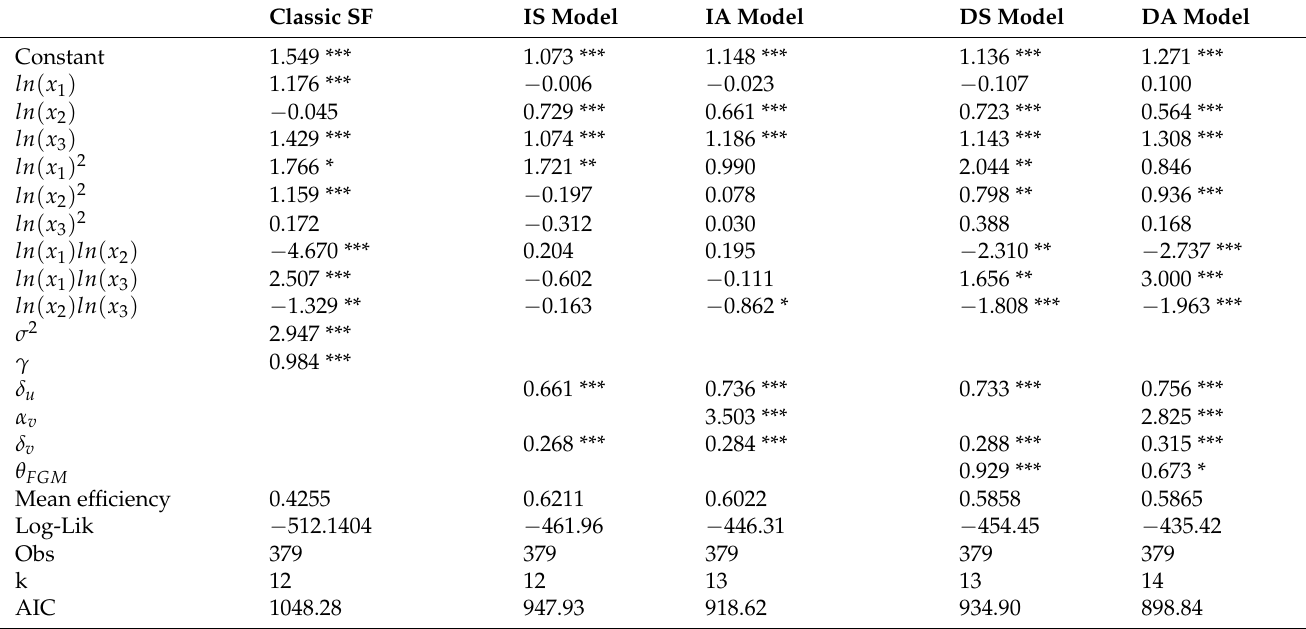
Table 1. Estimated production frontiers on data of Italian